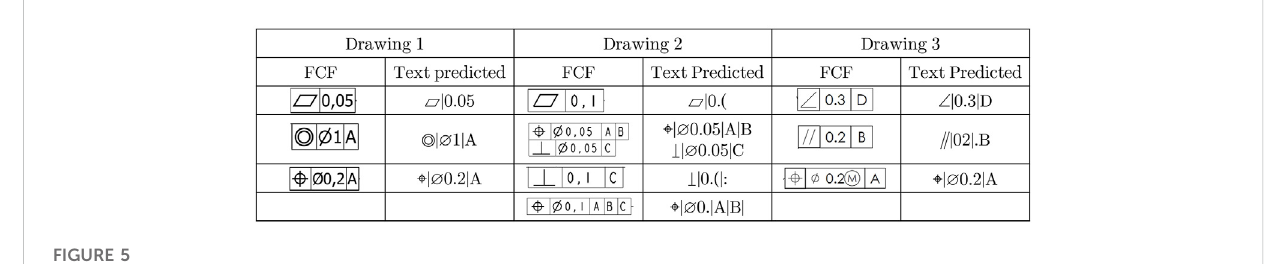
FIGURE 5 Results from the GD&T pipeline for three different mechanical